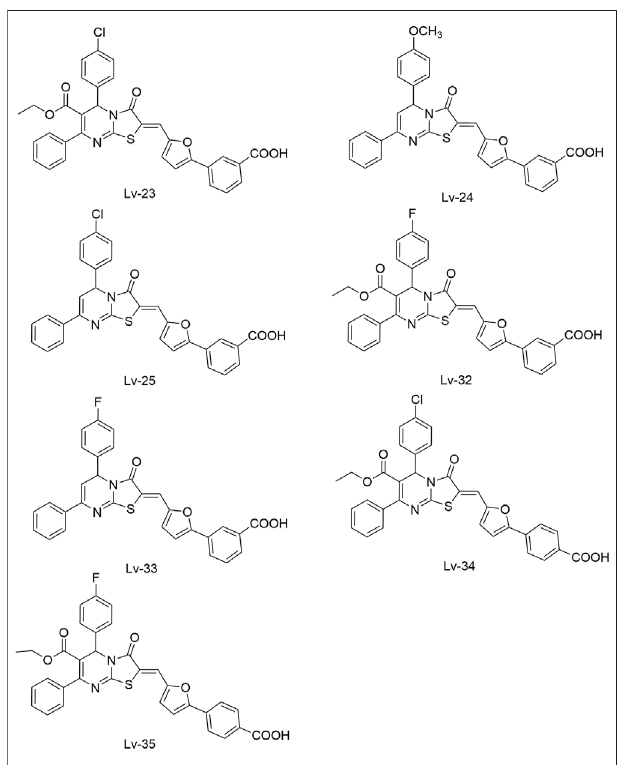
FIGURE 7 | The chemical structures of Lv-23, Lv-24, Lv-25, Lv-32, Lv- 33, Lv-34, and Lv-35.